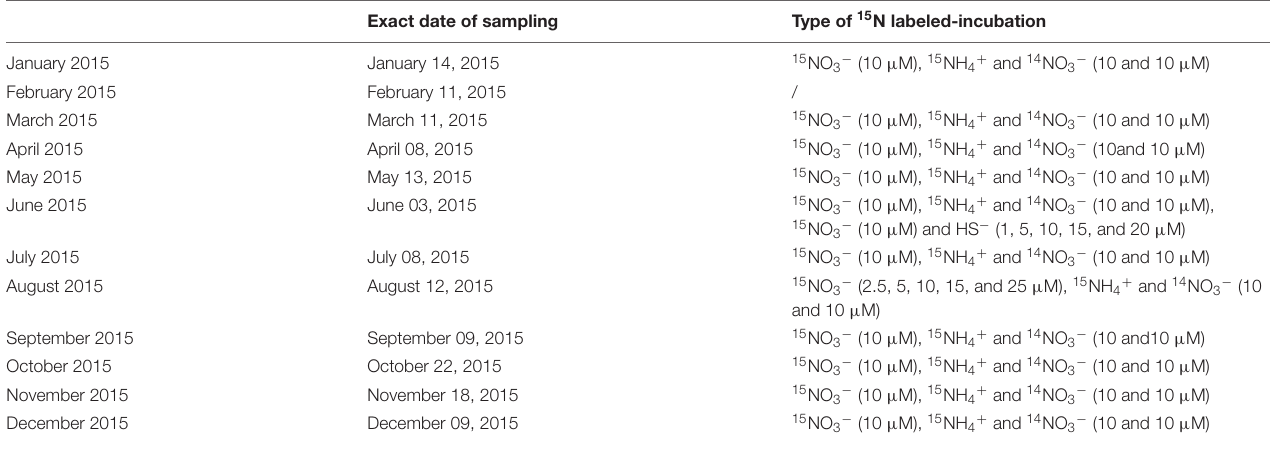
TABLE 1 | Addition of labeled N-species and electron donors to incubations in